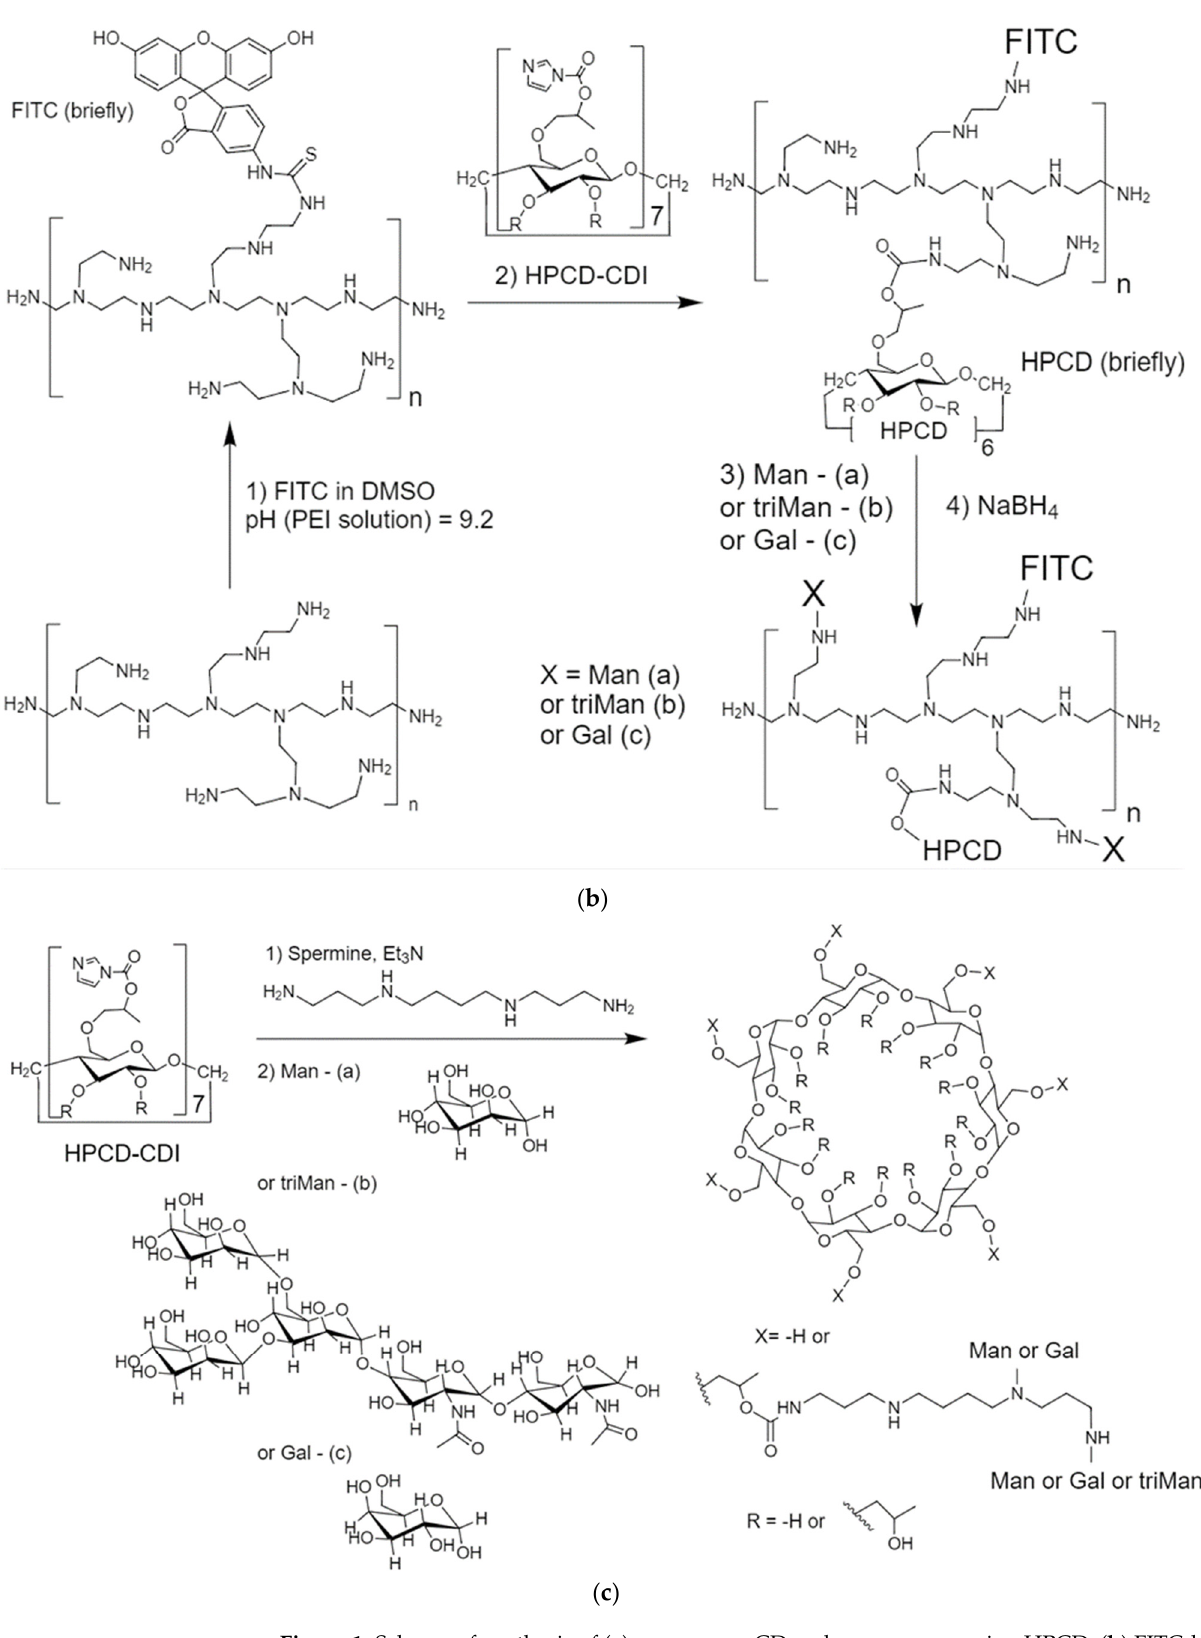
Figure 1. Scheme of synthesis of ( a ) mannan-amCD and mannan-spermine-HPCD, ( b ) FITC-labeled HPCD-PEI1.8 with grafted Man or Gal or triMan, ( c ) FITC-labeled star-shaped HPCD-spermine with grafted Man or Gal or triMan.